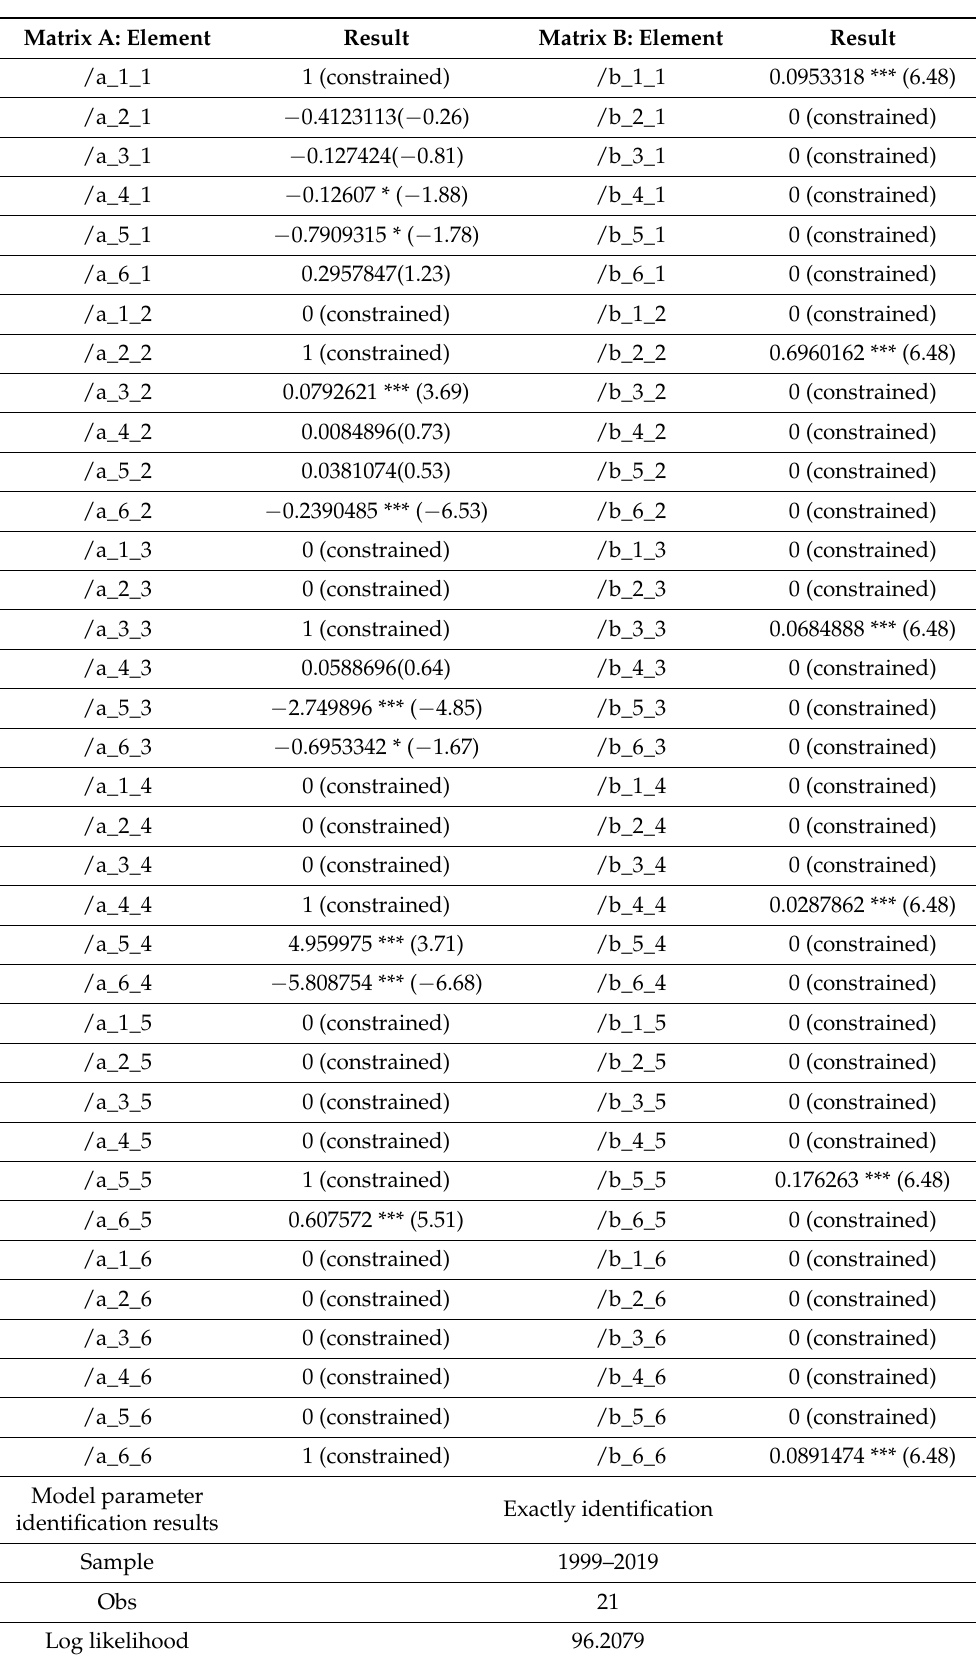
Table A4. Parameter estimation results of “AB model” of